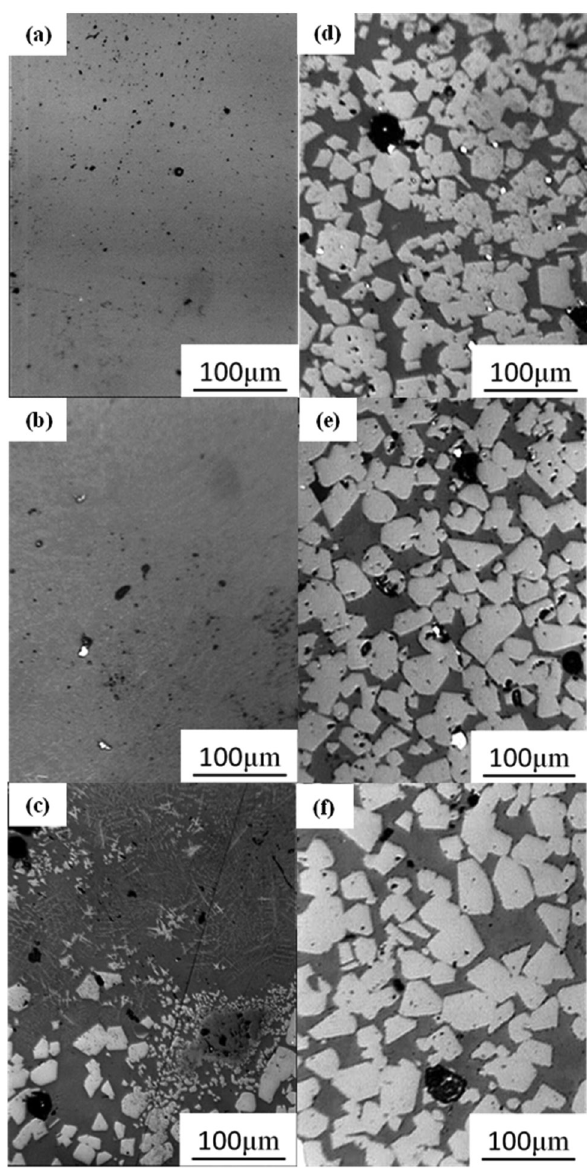
Fig. 5: Micrographs of six areas of the sample achieved by centrifugal concentration at G = 1050, t = 30 min, T = 1523 K.